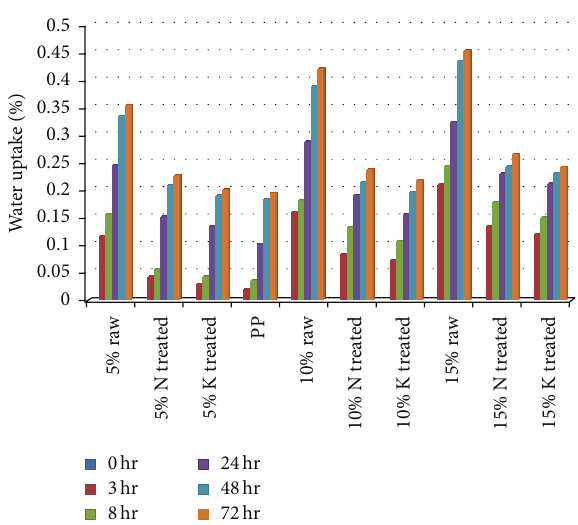
Figure 3: Water uptake for treated and untreated BBF/PP compos- ites for time interval 0 ∼ 72